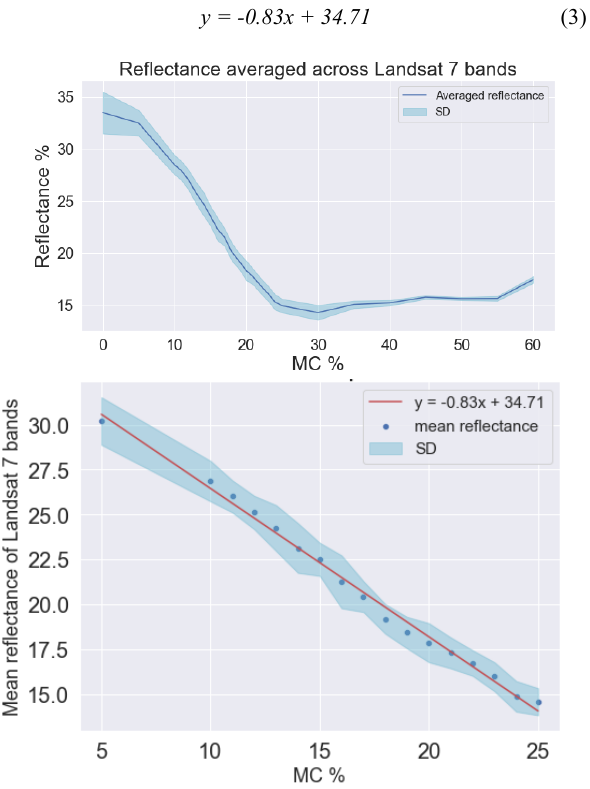
Figure 3(a & b). A linear regression model between soil reflectance averaged across the Landsat 7 wavelengths and MC returns an excellent fit for the domain of 5 to 25% MC.